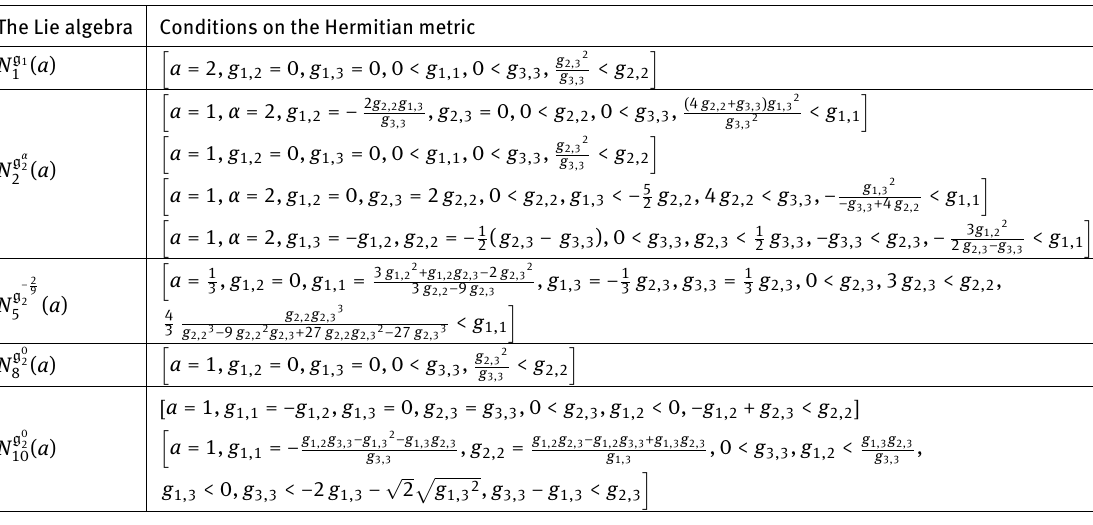
Table 8: Examples of Calabi-Yau with torsion Lie algebras which are not infinitely balanced